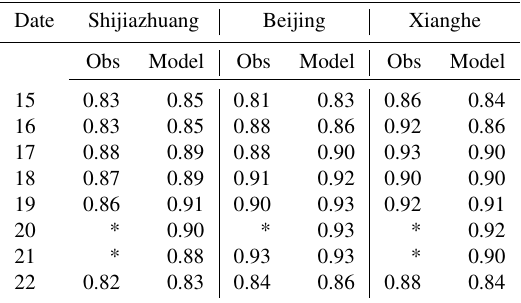
Table 5. Observed and modelled daily SSA (* represents a shortage of observations). Dates refer to December